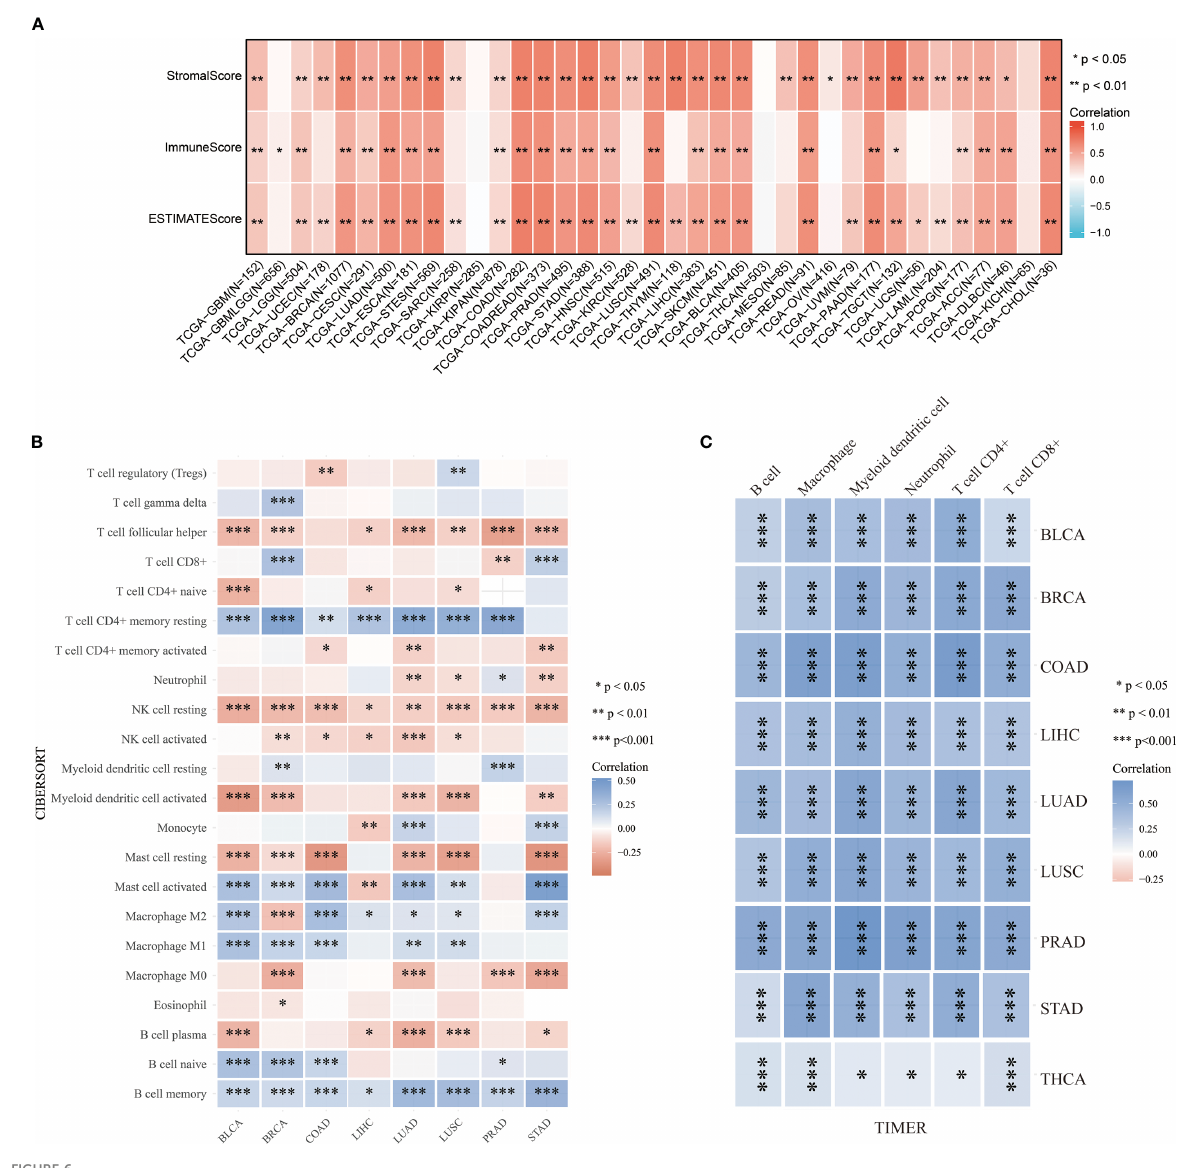
FIGURE 6 Analysis of tumor immune in fi ltration score for ABI3BP. (A) ABI3BP tumor estimation score analysis, stromal score analysis and tumor immune in fi ltration analysis. (B, C) CIBERSORT and TIMER algorithms analyzed the level of immune cell in fi ltration. *, p < 0.05; **, p < 0.01; ***, p <